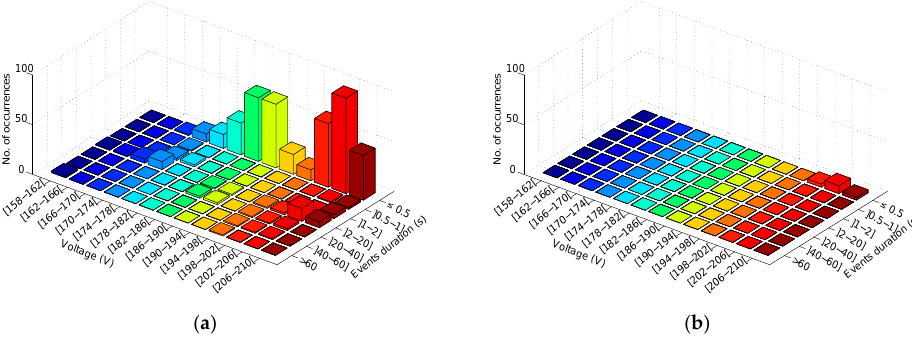
Figure 11. Statistical 3D voltage distributions for all recorded data: ( a ) dips before the grid strengthening; and ( b ) dips after the grid strengthening.